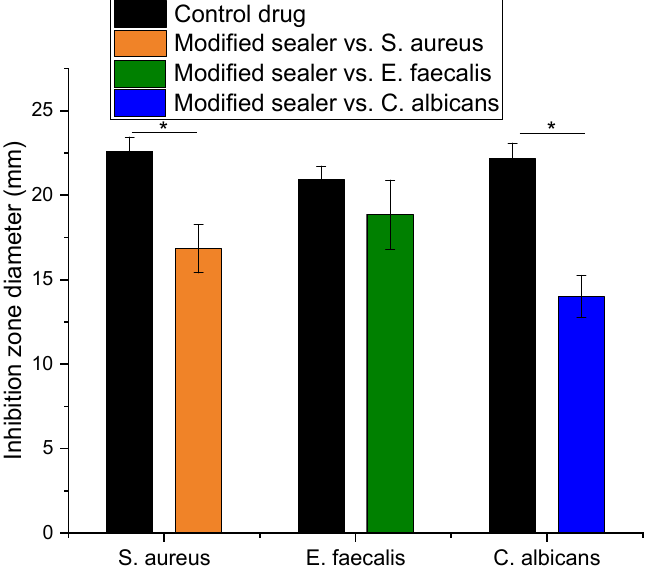
Figure 11. Diameter of inhibition zone in agar-diffusion assay with modified sealer and control drugs. Data are expressed as average value ± standard deviation of triplicate samples (* p < 0.05).